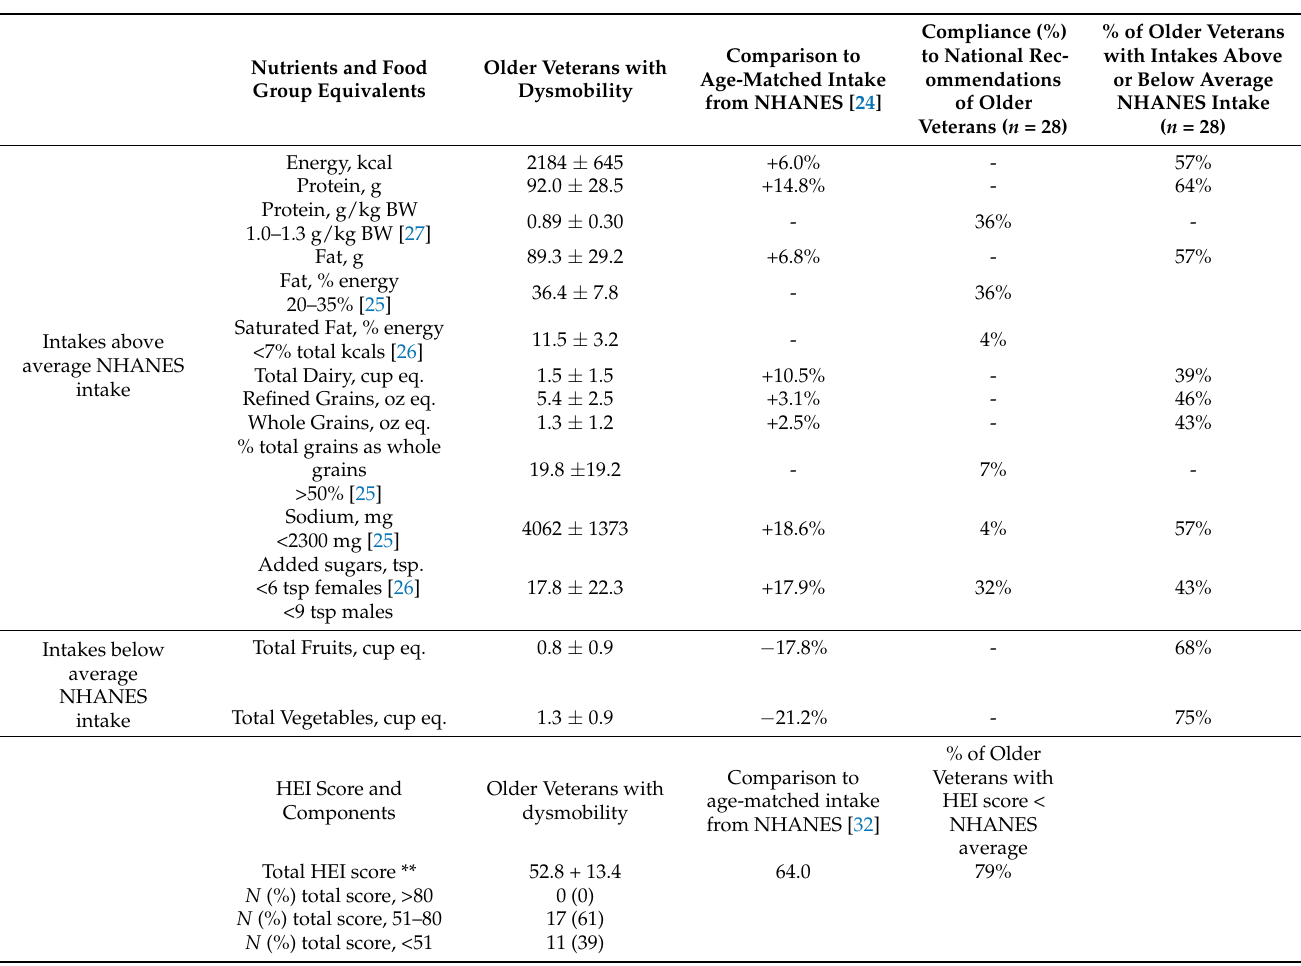
Table 2. Mean dietary intake and HEI of older Veterans with dysmobility enrolled in an exercise and nutrition randomized controlled trial with comparisons to national averages and national dietary recommendations